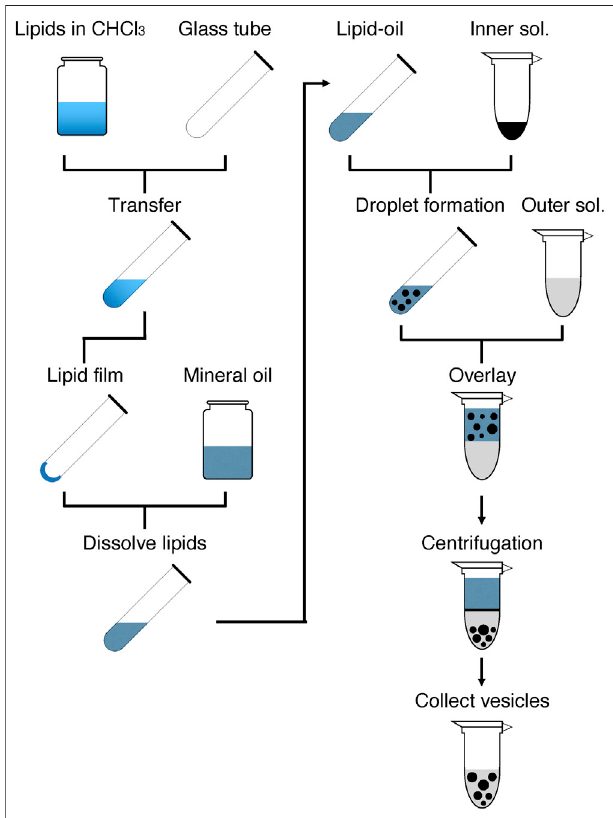
FIGURE1| Overviewoftherapidandfacilepreparationofgiantvesicles. The left half shows the steps for the preparation of lipid-oil mixture, and the righthalfshowsthestepsfortheformationofGVs.Thedetailsaredescribedin the Stepwise